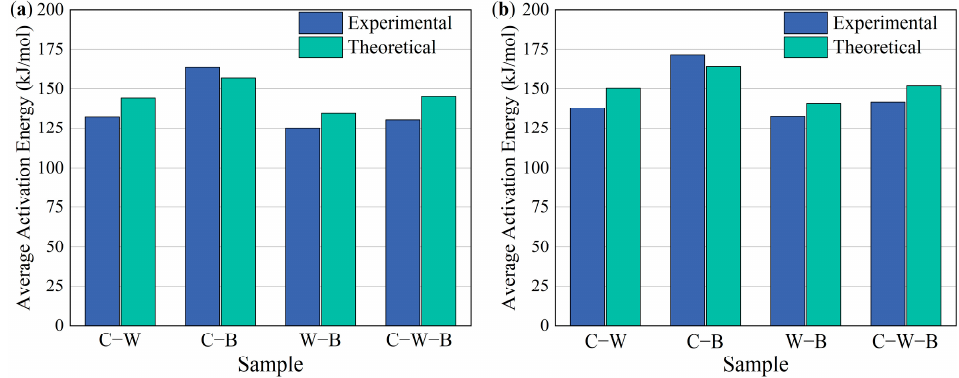
Figure 7. Comparison between the experimental and theoretical average activation energies of the tested blends: ( a ) KAS; ( b ) FWO.